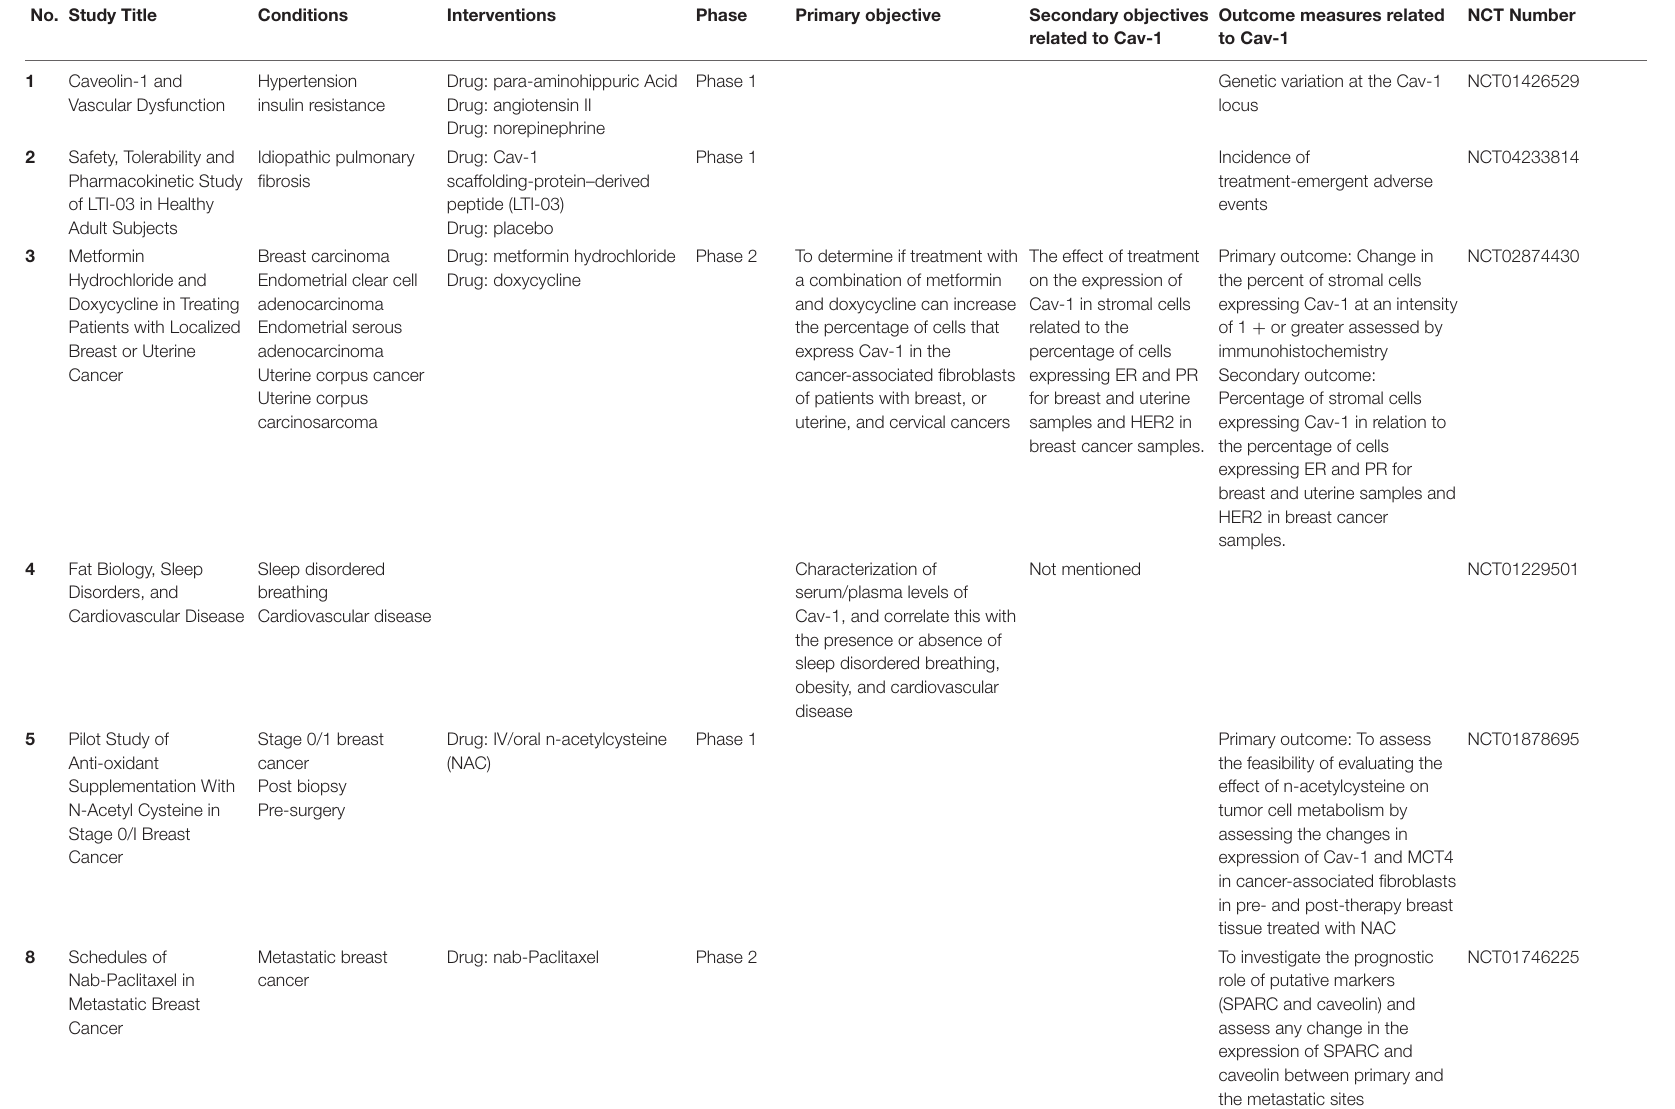
TABLE 2 | Clinical trials that include caveolin-1 as target or